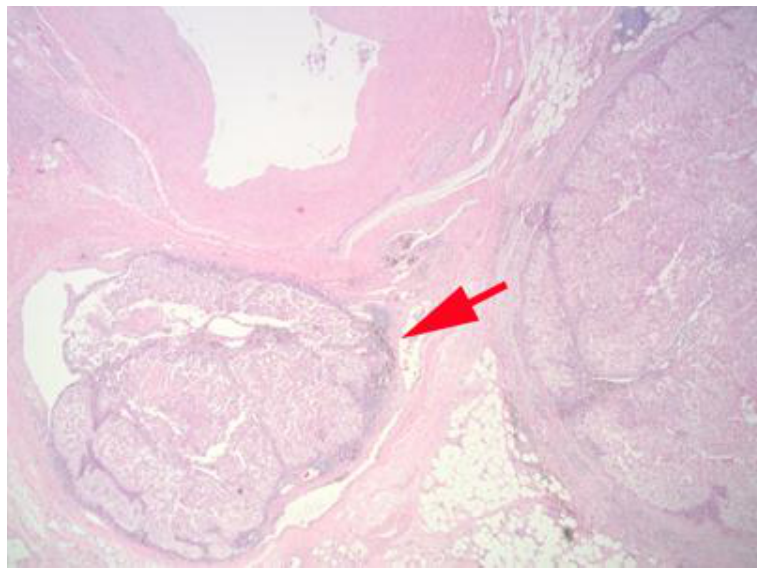
Figure 2B. Carcinoma within vascular channels within the renal sinus, regardless of size is also considered renal sinus